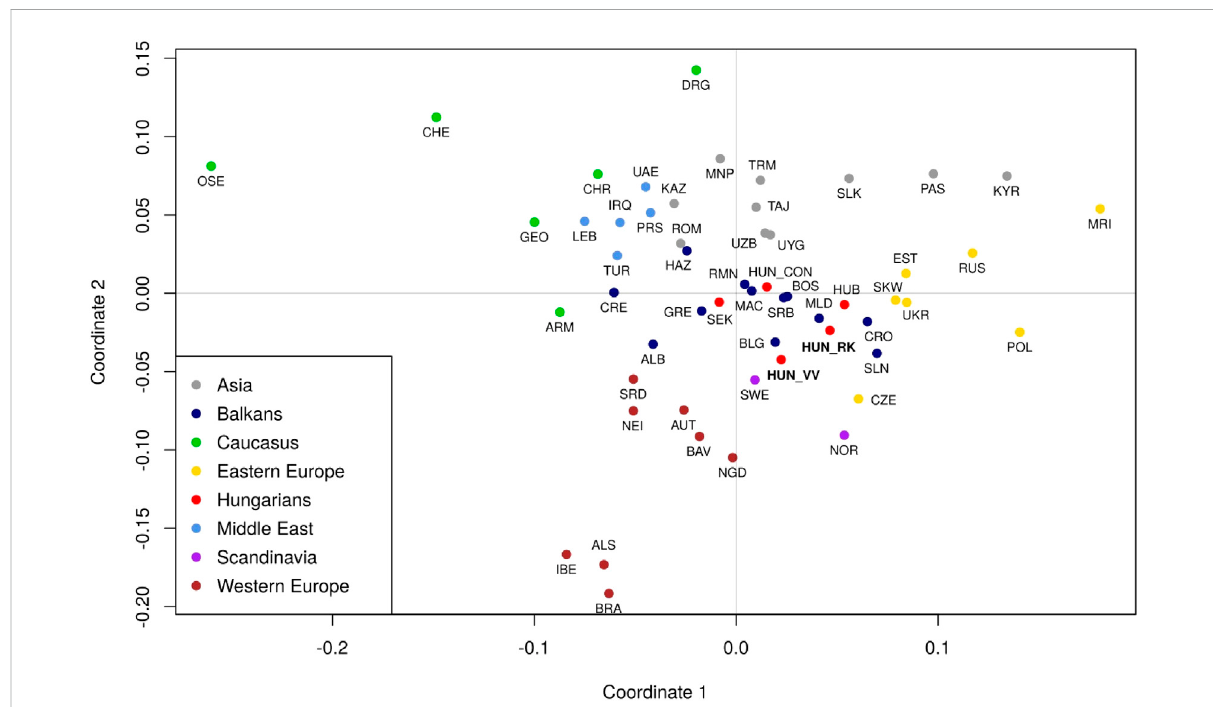
FIGURE 9 Multidimensional scaling (MDS) plot based on pairwise Fst genetic distances of 61 populations. The populations are colored based on their geographicallocations.ThereddotsindicateHungarianpopulations.Threepopulationsarehighlighted:Váhvalley(HUN_VV)andRétköz(HUN_RK) in bolded red font and Hungarian Conquerors (HUN_CON) in italic red font. Population abbreviations are de fi ned in Supplementary Table S3. Pairwise Fst genetic distances and p -values between 61 populations were calculated as shown in Supplementary Table